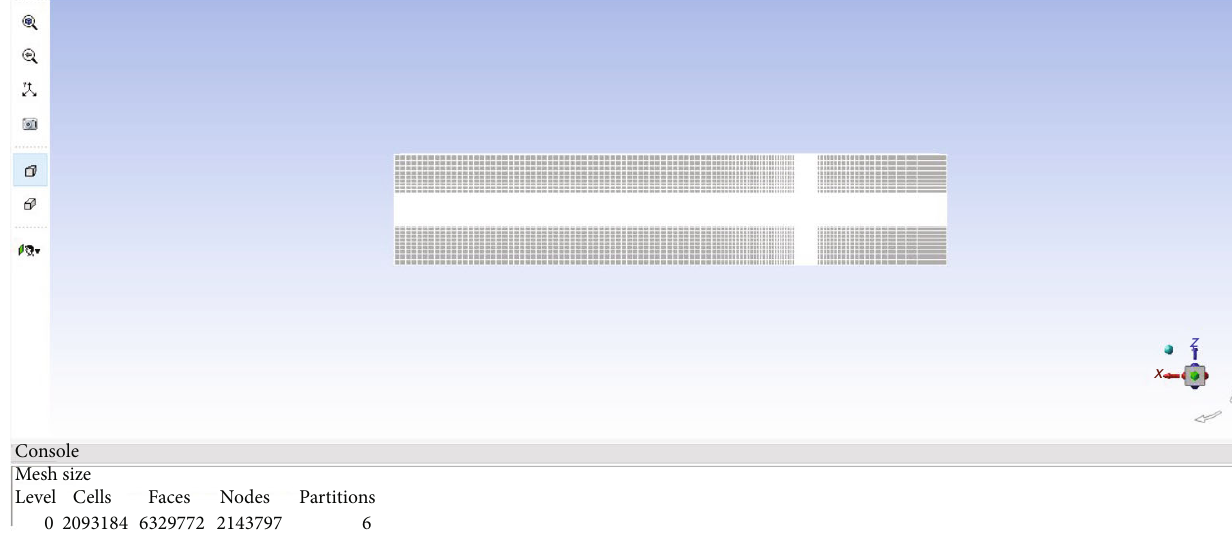
Figure 15: Vertical viewing of the re fi ned mesh.